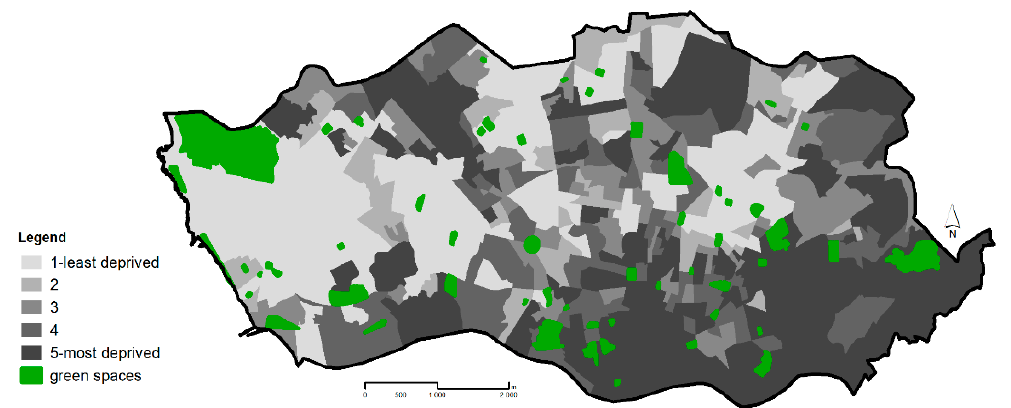
Figure 1. Geographic distribution of the public green spaces and neighbourhood socioeconomic deprivation in Porto municipality.